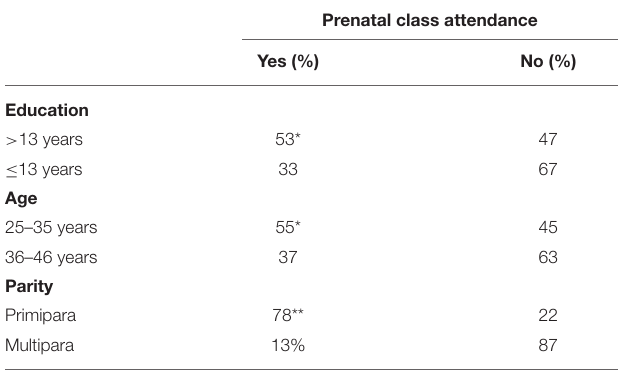
TABLE 3 | Association between basic characteristics of enrolled mothers and birth class attendance.